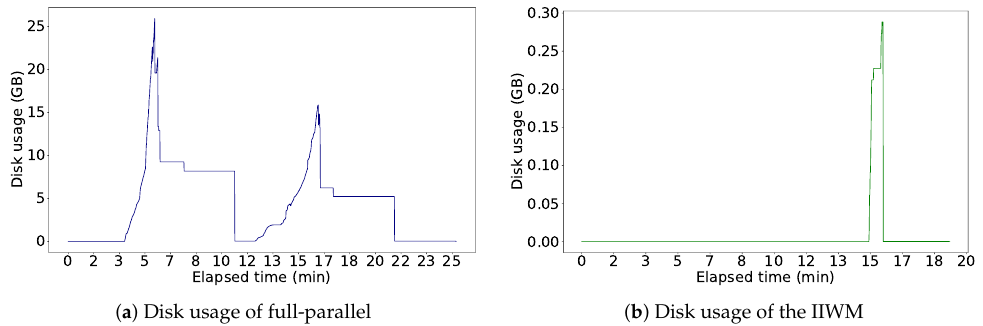
Figure 8. Disk usage over time for full-parallel and the IIWM.